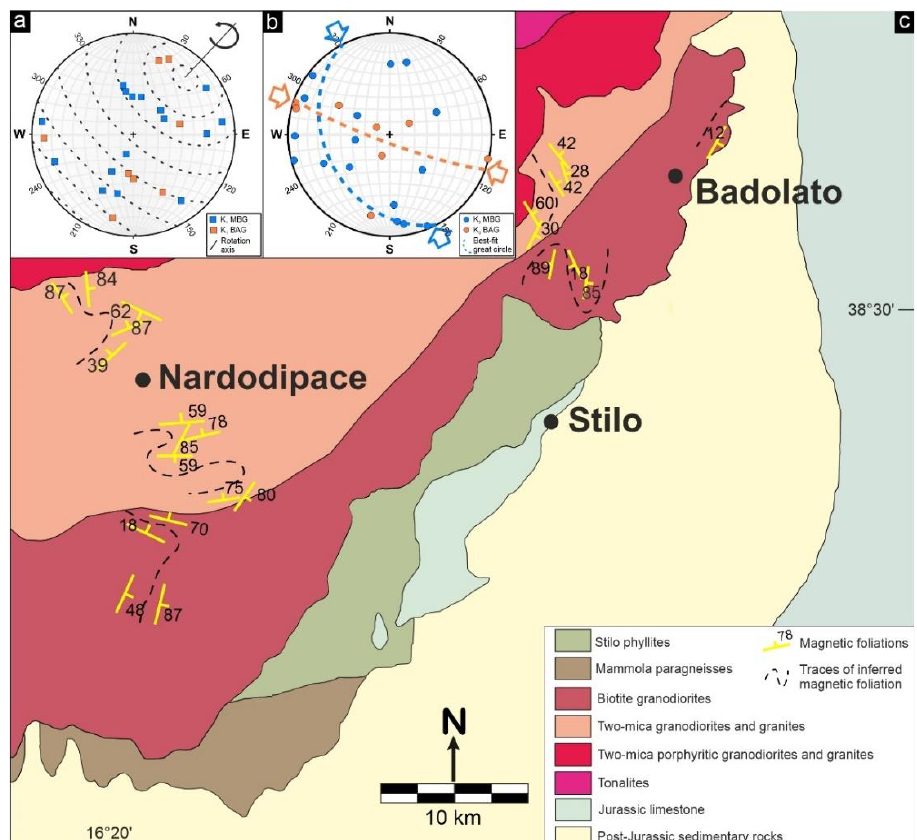
Figure 10. ( a ) Lower hemisphere equal-area projection of magnetic lineations (K 1 ), with interpreted dispersion of lineations along small circles (black dashed lines) around a gently N–E dipping rotation axis (42°/25° in trend/plunge format); ( b ) lower hemisphere equal-area projection of magnetic foliation (K 3 ), with orientation of inferred shortening axes (orange and light blue arrows for BAG and MBG, respectively); ( c ) interpretative map of magnetic foliation trajectories.